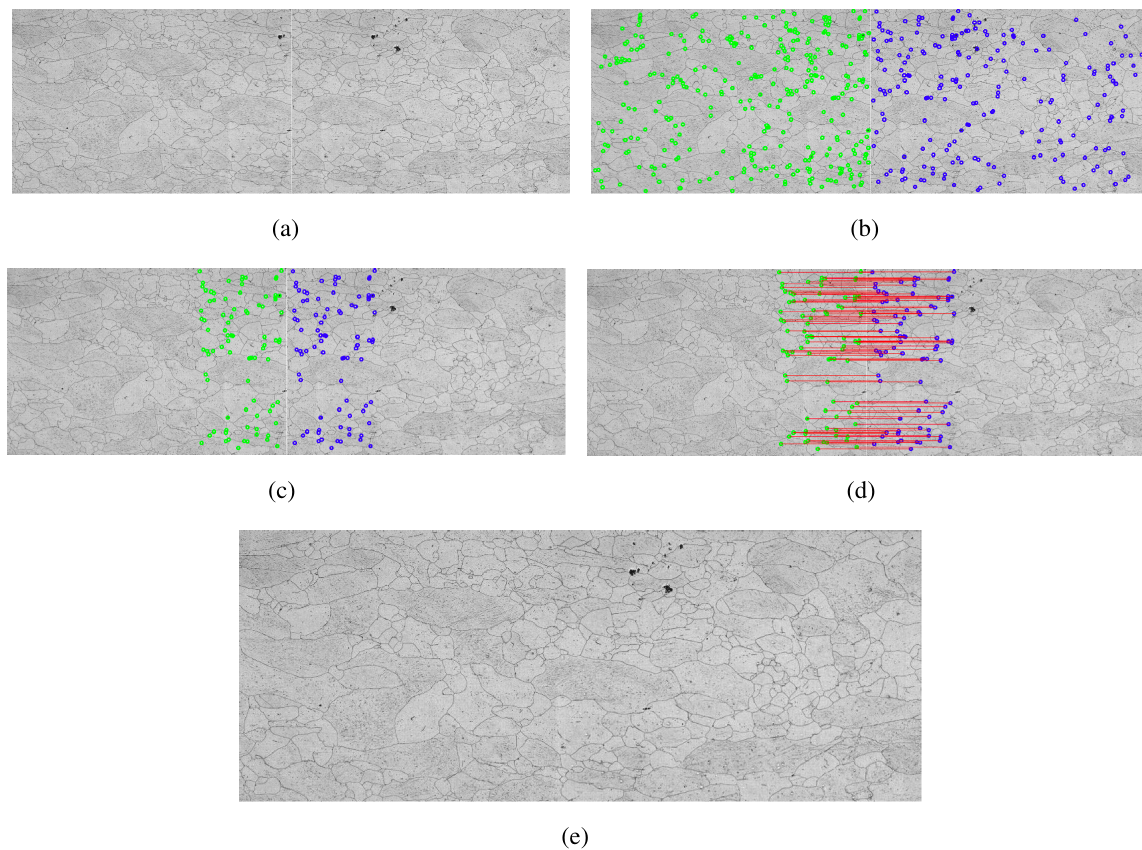
Figure 4. Example of the step by step construction using Transformed SIFT, ( a ) two adjacent frames with common points; ( b ) key points located by the Transformed SIFT; ( c ) choice of possible candidates for common points; ( d ) calculation of the nearest neighbor, and end result, grouped images; ( e ) mosaic